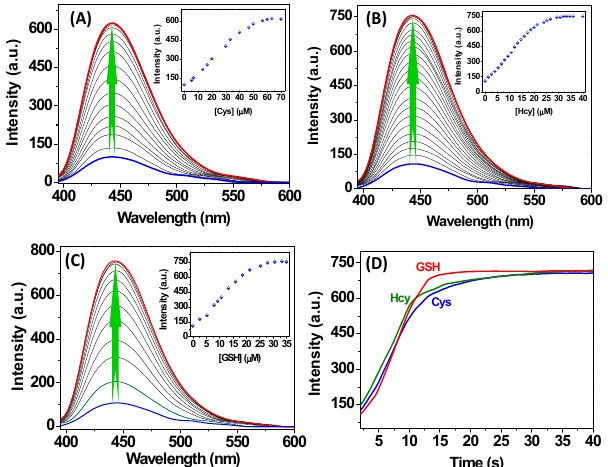
Figure 5. Fluorescence spectra of L -Cu 2 + (10 µ M) in the DMF / HEPES mixed solution (7:3, v / v , pH = 7.4) upon incremental addition of ( A ) Cys (0-70 µ M), ( B ) Hcy (0-40 µ M) and ( C ) GSH (0-35 µ M). Inset: the plots of the fluorescence intensity of L -Cu 2 + at 443 nm as the function of biothiols concentrations, respectively. ( D ) Time-dependent fluorescence intensity of L -Cu 2 + (10 µ M) at 443 nm upon incremental addition of Cys (0-70 µ M), Hcy (0-40 µ M) and GSH (0-35 µ M) in the DMF / HEPES mixed solution (7:3, v / v , pH = 7.4). The intensities were recorded at 443 nm, excitation was performed at 378 nm.